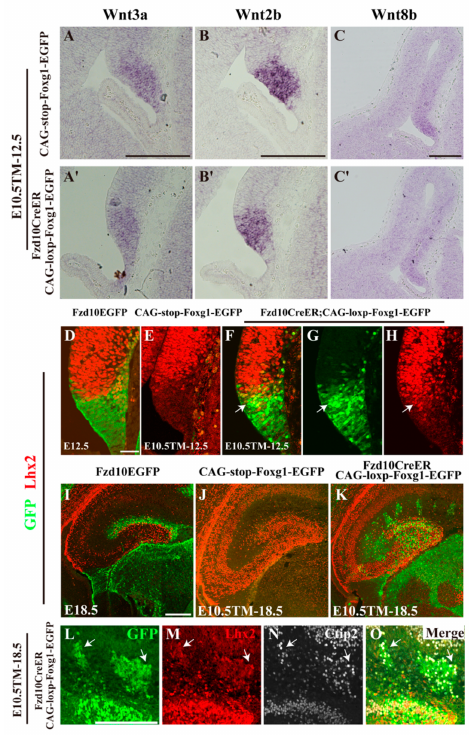
Figure 5. Normal morphology of the hem and ectopic expression of Lhx2. ( A – C (cid:48) ) In situ hybridization assay of Wnt3a ( A , A (cid:48) ), Wnt2b ( B , B (cid:48) ), and Wnt8b ( C , C (cid:48) ) on coronal sections of E12.5 CAG-loxp-stop-loxp-Foxg1-IRES-EGFP ( A – C ) and Fzd10CreER TM ; CAG-loxp-Foxg1-IRES-EGFP embryos ( A (cid:48) – C (cid:48) ). ( D – K ) Double-immunofluorescence analysis of GFP with Lhx2 at E12.5 ( D – H ) and E18.5 ( I – K ). ( L – O ) Triple immunostaining for GFP/Lhx2/Ctip2 in E12.5 Fzd10CreER TM ; CAG-loxp-Foxg1-IRES-EGFP brains. The arrows show the triple-labelled cells. Scale bars: 200 µ m (( D – G ) 50 µ